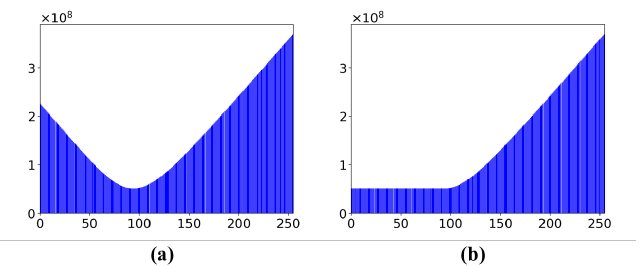
Figure 6. Comparison of LC and restricted LC: ( a ) the saliency values of the gray values using original LC algorithm; ( b ) the saliency values using restricted LC